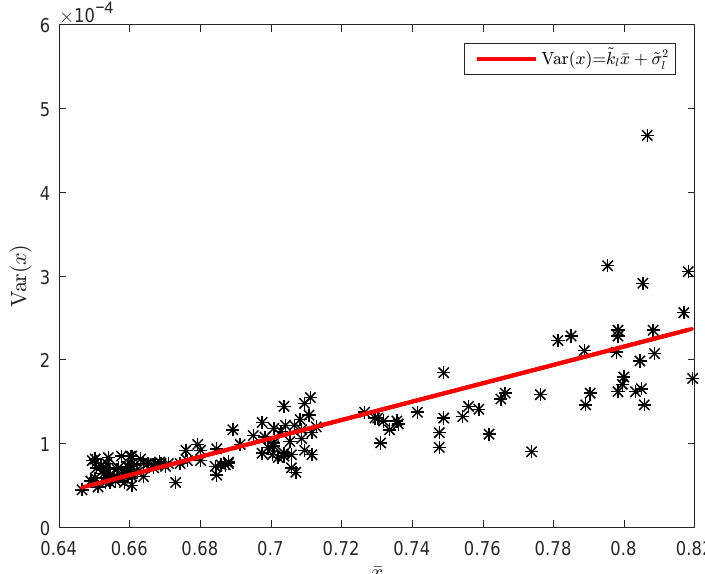
Figure 3. The sample points and fit line of a band in HSI